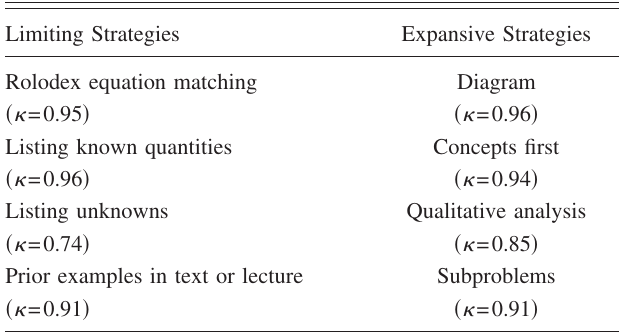
TABLE I. Categories used to code student reflections. (cid:2) values for inter-rater reliability are listed below each